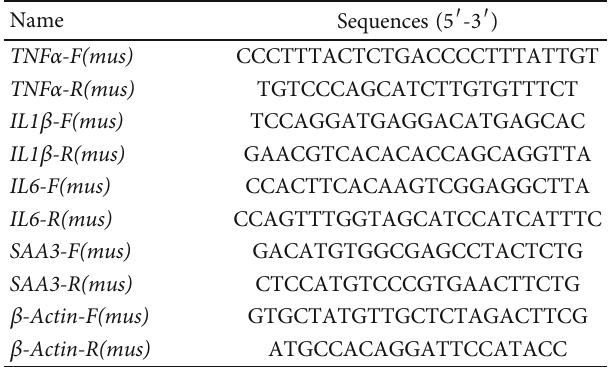
Table 1: Primer sequences of genes.